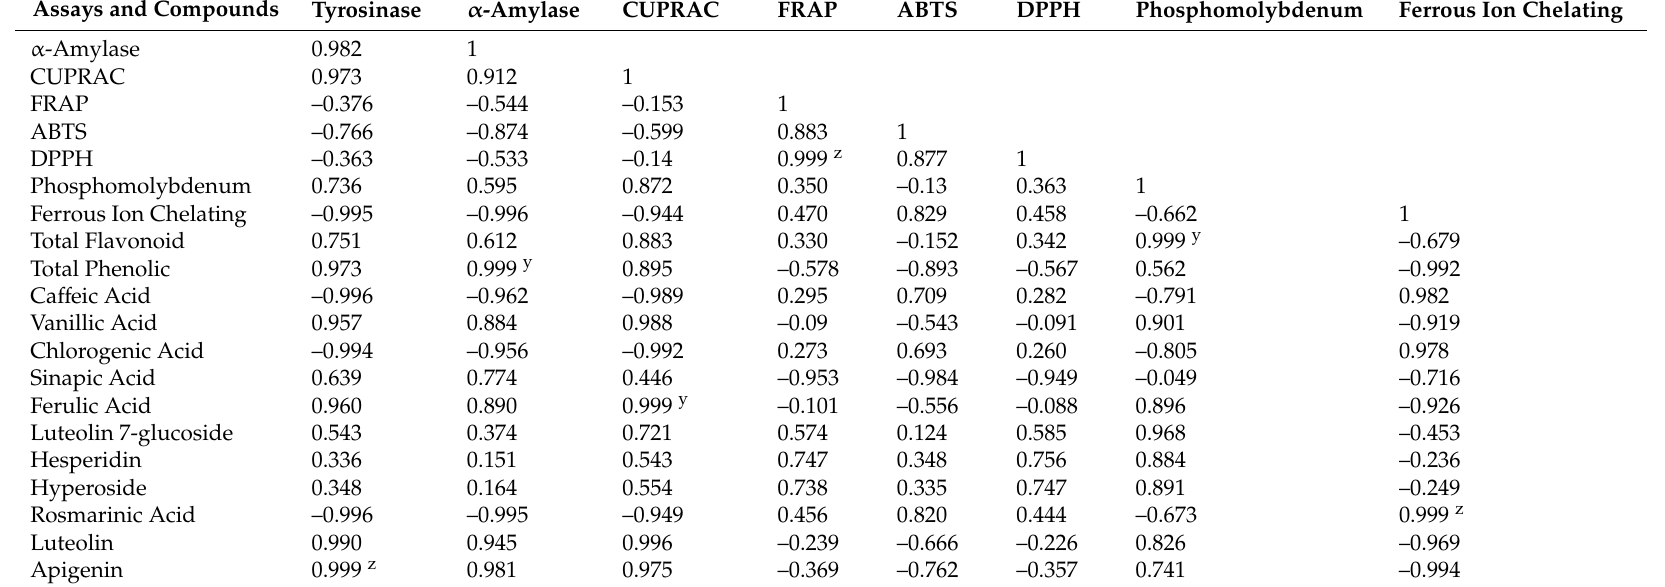
Table 5. Correlations among phenolic compounds and assays x